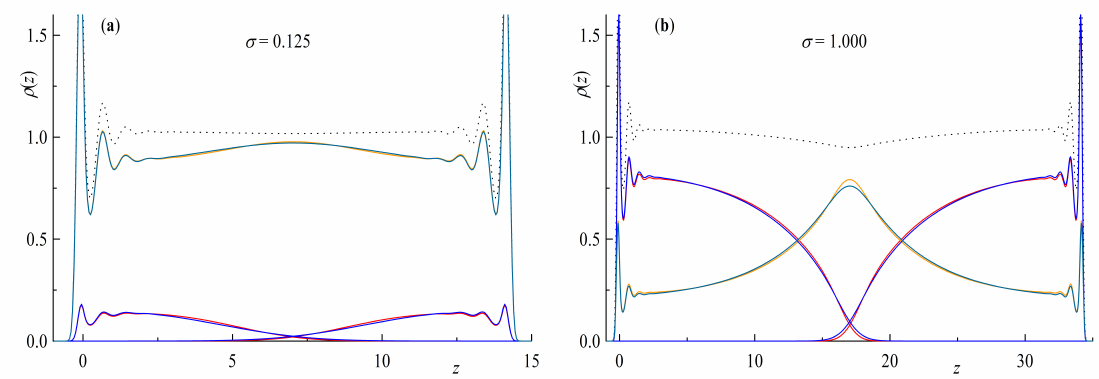
Figure 1. Bead density ρ ( z ) as a function of distance from surface z for a double layer brush system with a surface coverage of ( a ) σ = 0.125 brush distance D = 14 z and ( b ) σ = 1.000 and D = 34 z . Red lines are rings N = 64, blue for tails N = 32, orange and turquoise for solvent of the ring and linear chain simulations respectively. The dotted line depicts the total bead density of the simulation